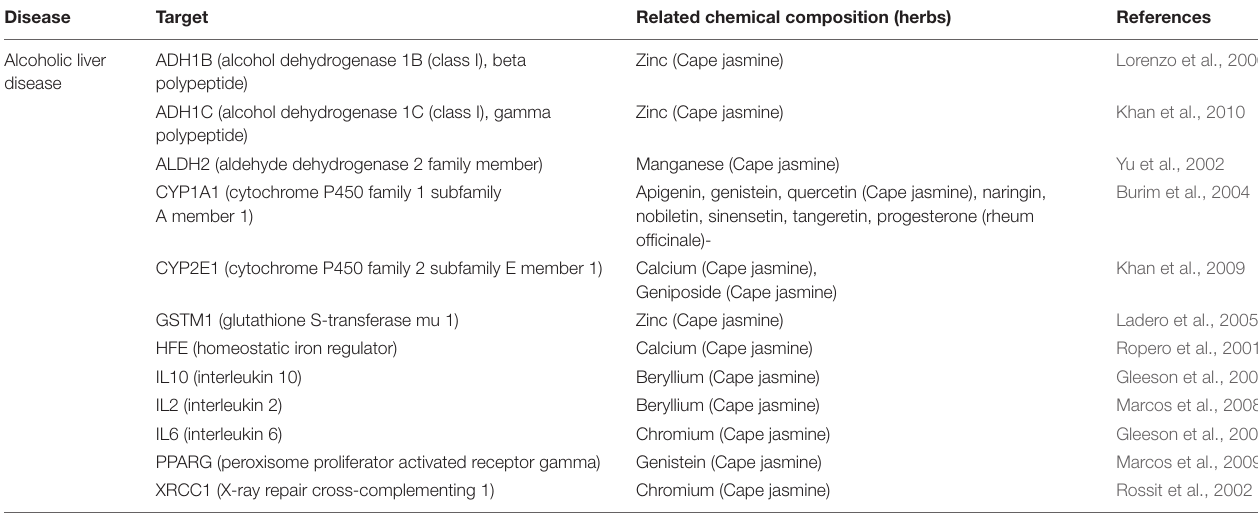
TABLE 5 | Candidate targets of ZZDHT for alcoholic liver disease validated by TCM-Mesh. Disease